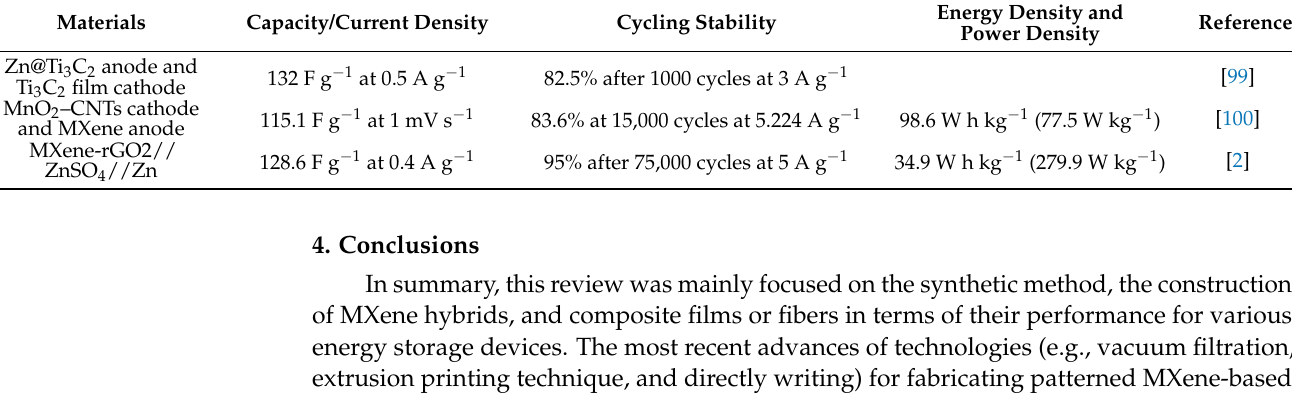
Table 3. Comparison of the electrochemical properties of different MXene-based materials for Zn ions storage devices.